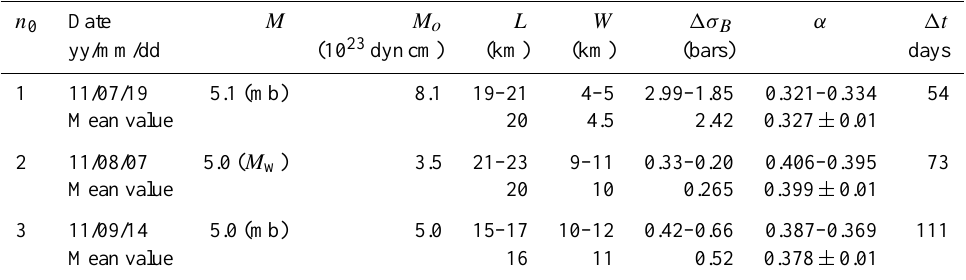
Table 1. The USGS reported date and magnitude of the 3 main shocks along with their seismic moment, range of values in the dimensions of their aftershock area L and W , corresponding calculated values for 1σ B , the critical exponent α and the lead time 1t . Mean values are also given for each